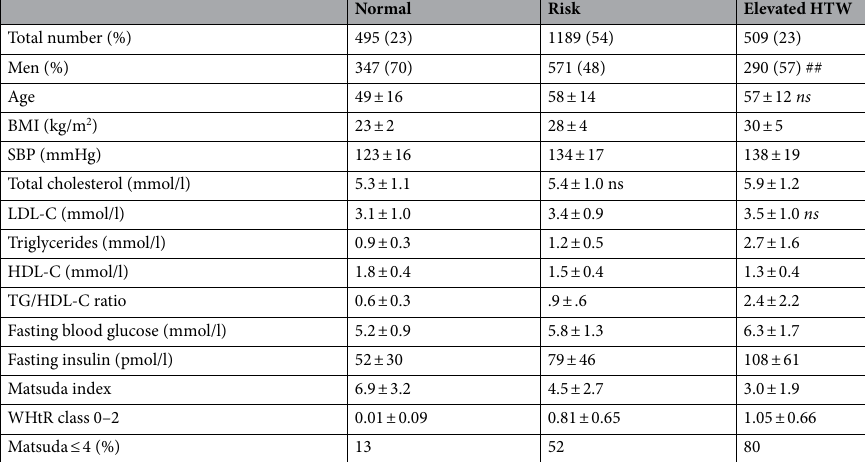
Table 3. Subgroups of hypertriglyceridemic-waist phenotype: differences between the groups are p < 0.001 unless indicated otherwise. Data are given as mean ± standard deviation. In comparison to normal ns = no significance, * p < .05 and ** p < 0.01. In comparison to risk ns = no significance, #p < 0.05 and ##p < 0.01. Normal, risk and elevated HTW are defined in the method section. SBP systolic blood pressure, WHtR classes as normal, risk and elevated are defined in the method section.